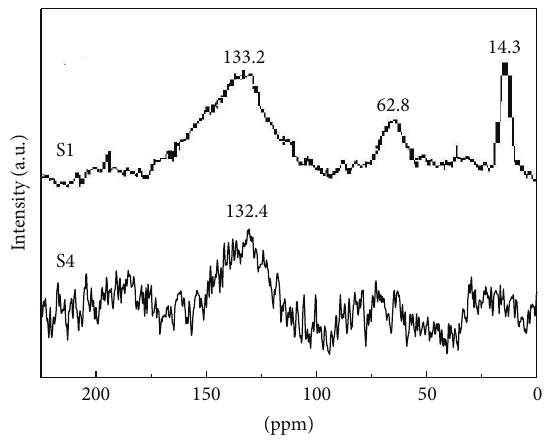
Figure 1: 13 C-NMR spectra of S1 and S4.